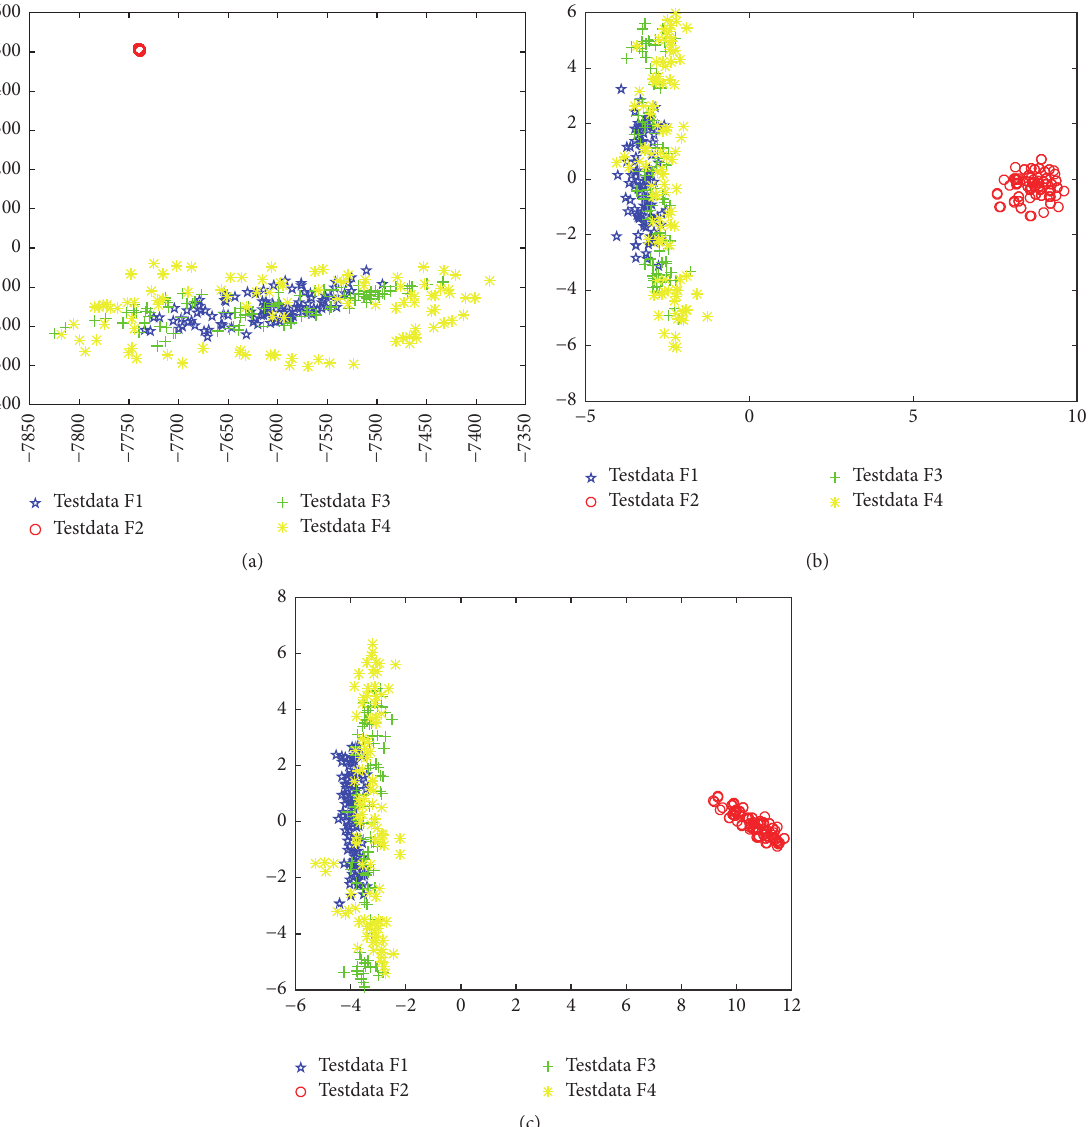
Figure 2: Feature extraction to TE process: (a) PCA. (b) DSPCA. (c)